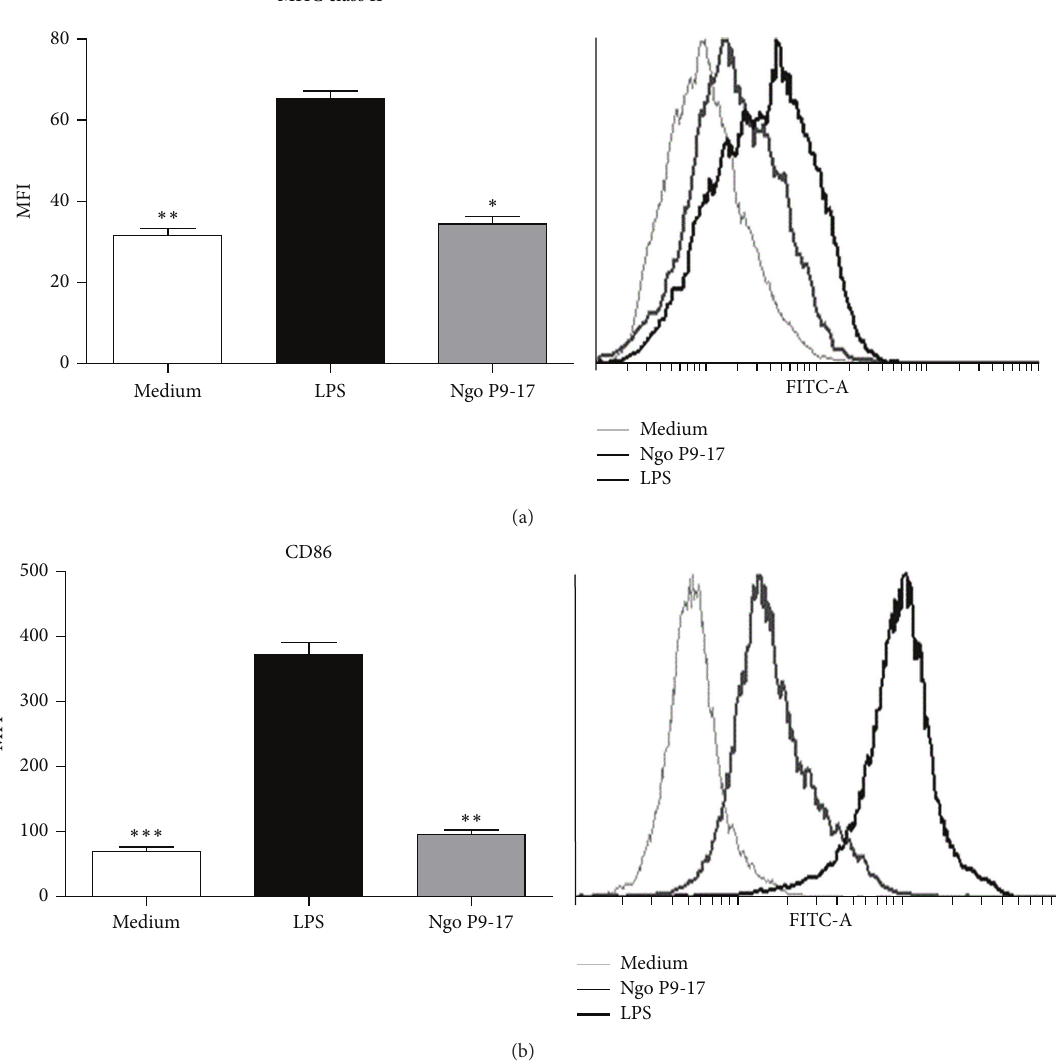
Figure 3: Quantification of MHC II and CD86 expression on the surface of gonococcus-infected RAW cells using flow cytometry. Macrophages were stained with anti-CD11b specific antibodies. (a) MHC class II in RAW cells, 𝑛 = 6 . (b) CD86 in RAW cells, 𝑛 = 8 . Bars represent mean ± SEM of independent experiments. Representative histogram plot are shown in the right panel. ∗ indicates that P9-17 induced lower levels of MHC II compared to levels induced by LPS, 𝑃 < 0.05 ; ∗∗ indicates that P9-17 induced lower levels of CD86 compared to levels induced by LPS, 𝑃 < 0.05